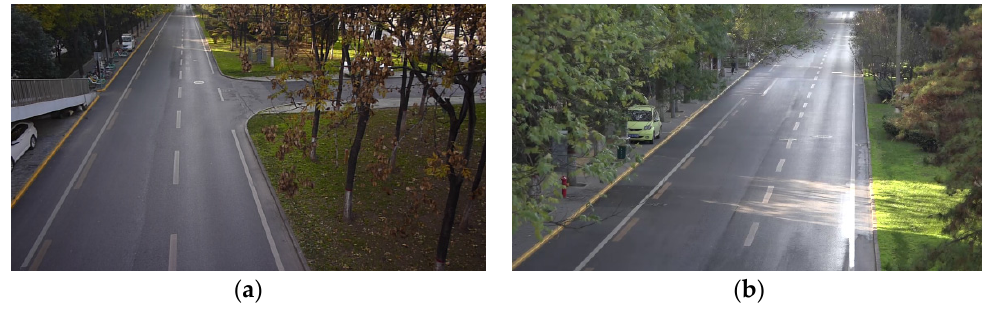
Table 4. Measurement of vehicle spatial distribution errors in dataset scene 2.